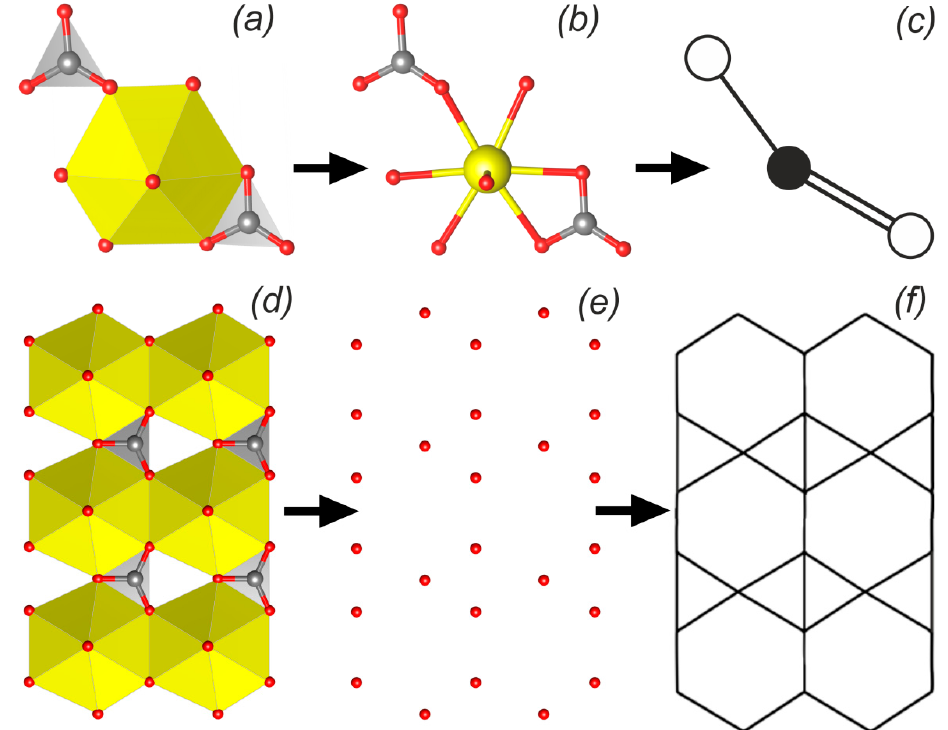
Figure 1. Illustration of building topologies. Combination of Ur bipyramid with edge- and vertex-shared triangular carbonate groups in polyhedral ( a ), ball-and-stick ( b ) representations, and respective black-and-white graph ( c ). Fragment of the dense uranyl-carbonate layer with edge-sharing interpolyhedral linkage ( d ), O atoms that are involved in linkage with more than one cation ( e ), and the resulted anion topology built on them ( f ). Legend: U-bearing coordination polyhedra = yellow; U atoms = yellow; C atoms = grey; O atoms = red; black nodes = U atoms, white nodes = C atoms; CO 3 groups are shown in a ball-and-stick model with grey filling; see Section 2.2 for details.